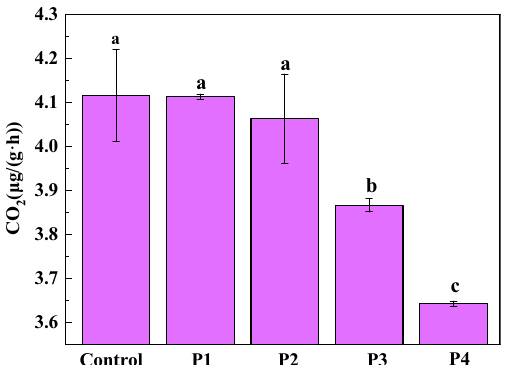
Figure 1. Effect of PG on soil respiration. Different lowercase letters represent significant differences at the level of P < 0.05.